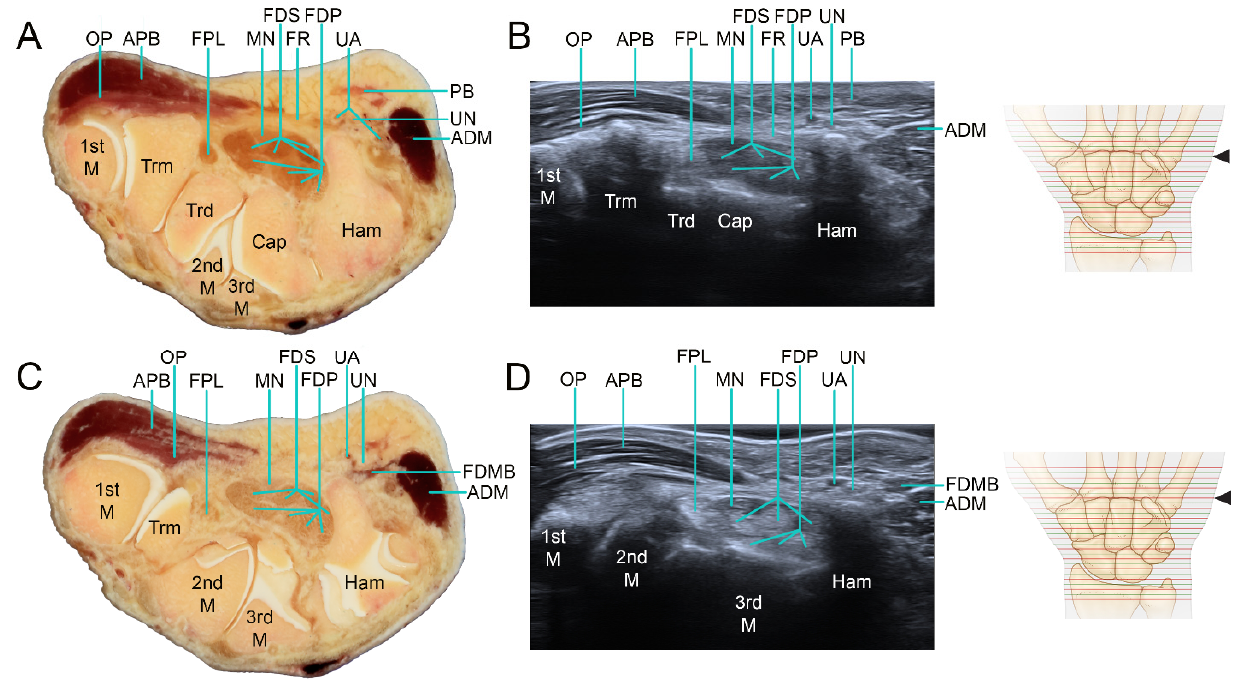
Figure 7. Sectioned images ( A , C ) and corresponding US ( B , D ) images for transverse views at the distal part of the distal carpal bones. ( A , B ) The first metacarpal (1st M) appears radial to the Trm. The second metacarpal (2nd M) and third metacarpal (3rd M) bases appear between the Trd and Cap. The hook of Ham is distinctive on the ulnar side of the FDS and FDP tendons. The APB and OP become thicker and extend to the middle of the flexor retinaculum (FR). The MN is between the second and third FDS tendons. The UA and UN are between the hook of hamate and the PB, radial to the ADM. The UA divides into branches. ( C , D ) At a more-distal level, the distal carpals articulate with the metacarpal bases. In the hypothenar eminence, the flexor digiti minimi brevis (FDMB) appears radial to the ADM. The MN lies between the second and third FDS tendons. The UA and UN are superficial to the FDMB and are radial to the ADM. Arrowheads in the schematics indicate the levels of the wrist scanned by the US